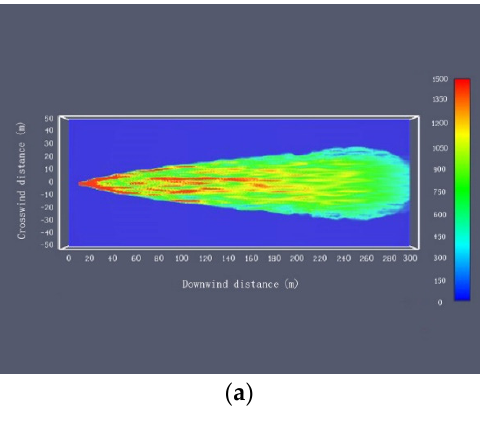
Figure 6. Distribution map of the diffusion concentration in the Z plane (H = 2 m) when the atmospheric environment is stable at t = 60 and 120 s (top view). ( a ) Concentration distribution of vinyl chloride in the Z plane at t = 60 s(ppm). ( b ) Concentration distribution of vinyl chloride in the Z plane at t = 120 s(ppm).